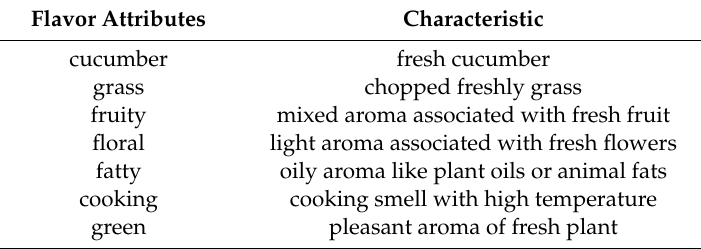
Table 1. Flavor attributes selected for sensory